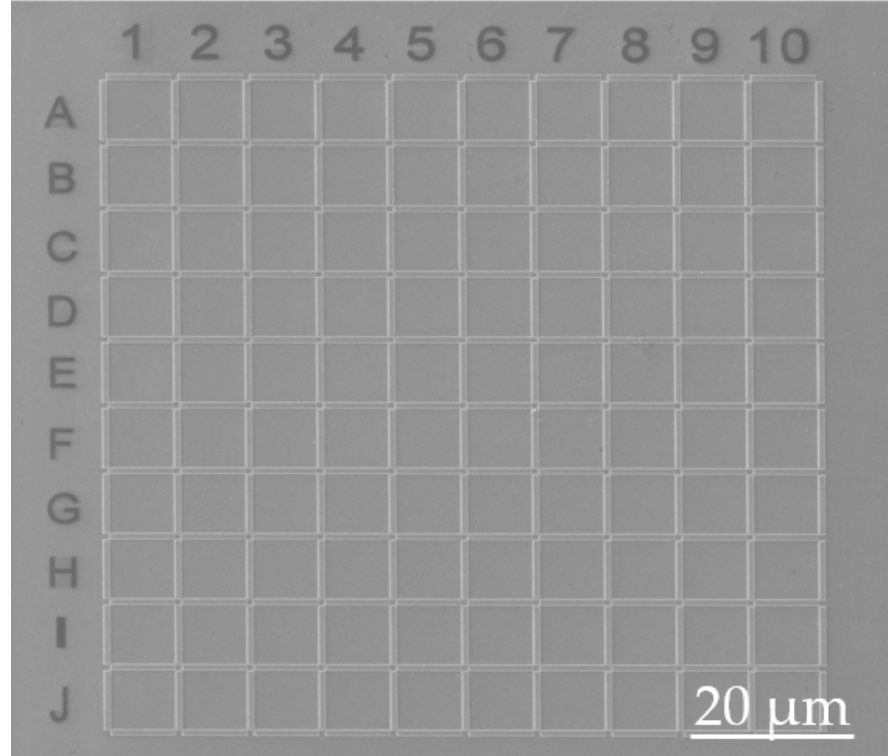
Figure 7. SEM micrograph of a Pt-C cryo-deposit grid-like array formed by 220 rectangles with ~9 μ m × 0.9 μ m area. The total Ga + irradiation time was only 43 s, which corresponds to an ion area dose of 23 μ C/cm 2 . The same array would fabricate by standard FIBID process in 2.5 h. This type of arrays